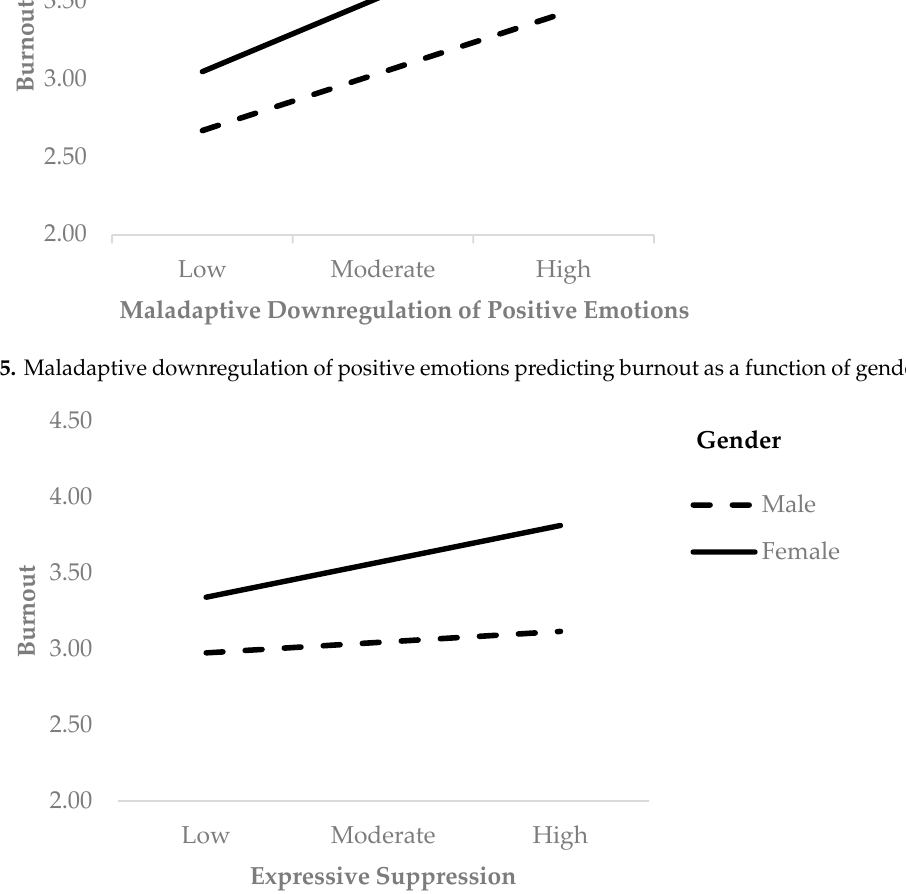
Figure 6. Expressive suppression predicting burnout as a function of gender.